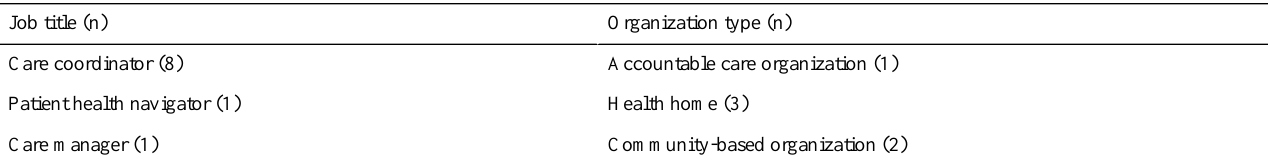
Table 2. Profile of